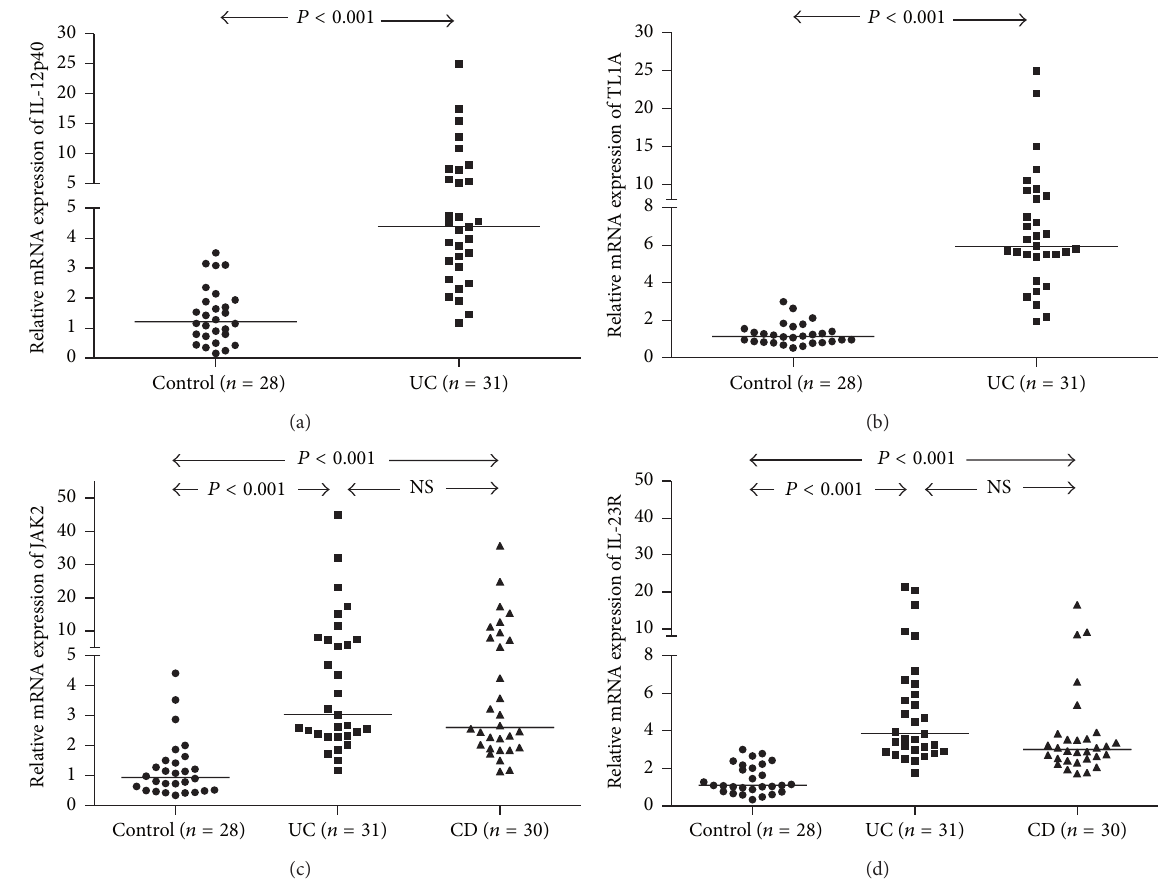
Figure 1: The mRNA expression of IL-23/Th17 pathway related genes in IBD patients. (a) and (b) The levels of IL-12p40 and TL1A mRNA expression were higher in UC patients than healthy controls ( 𝑃 < 0.001 ). (c) and (d) There was a highly significant increase in the expression of JAK2 and IL-23R in patients with UC and CD as compared to healthy controls ( 𝑃 < 0.001 , for both comparisons), but no significant difference was observed between UC and CD patients. The level of mRNA expression was normalized to that of 𝛽 -actin mRNA expression. Horizontal lines represent median values for each group and NS indicate no